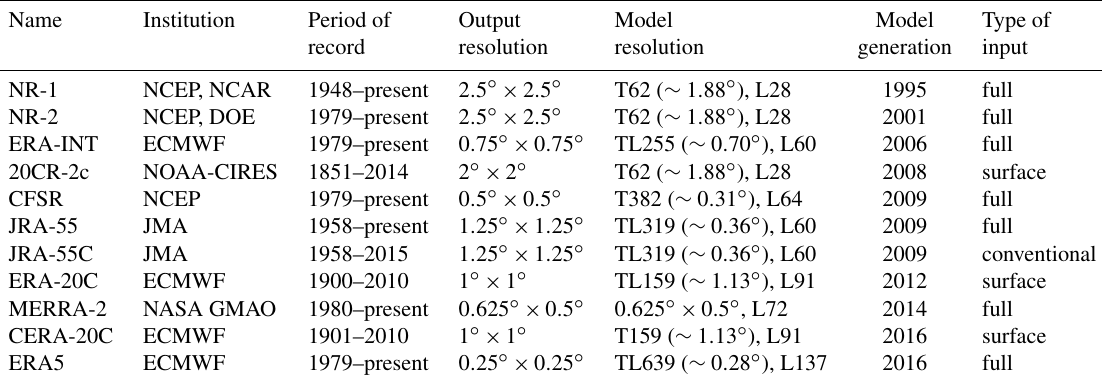
Table 1. Reanalysis datasets that can be read by